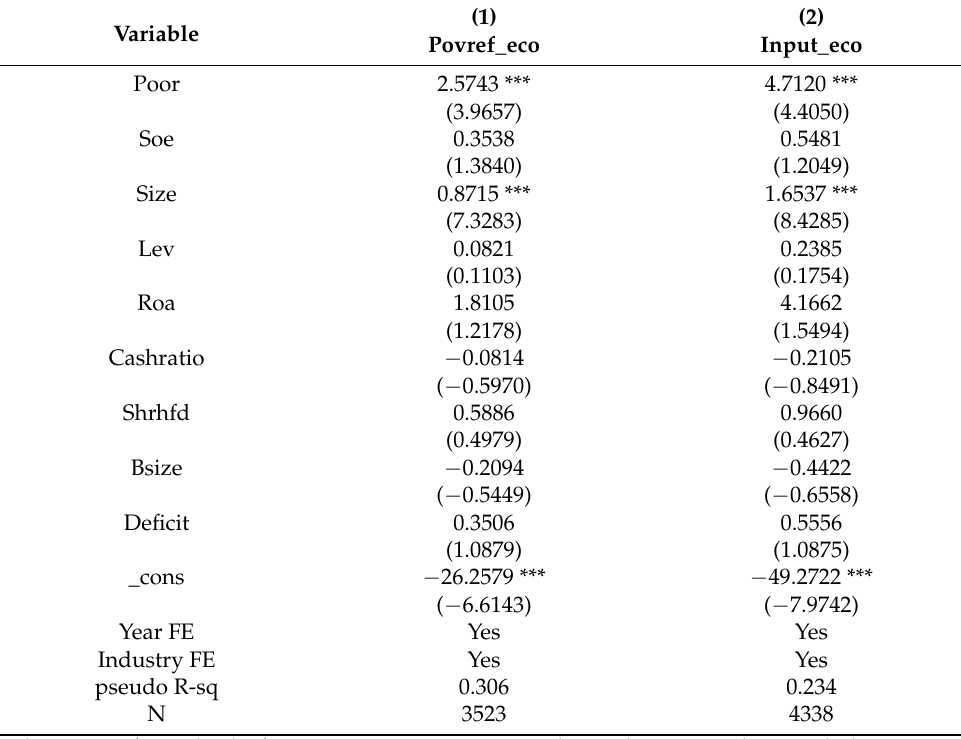
Table 5. Robustness tests: sample